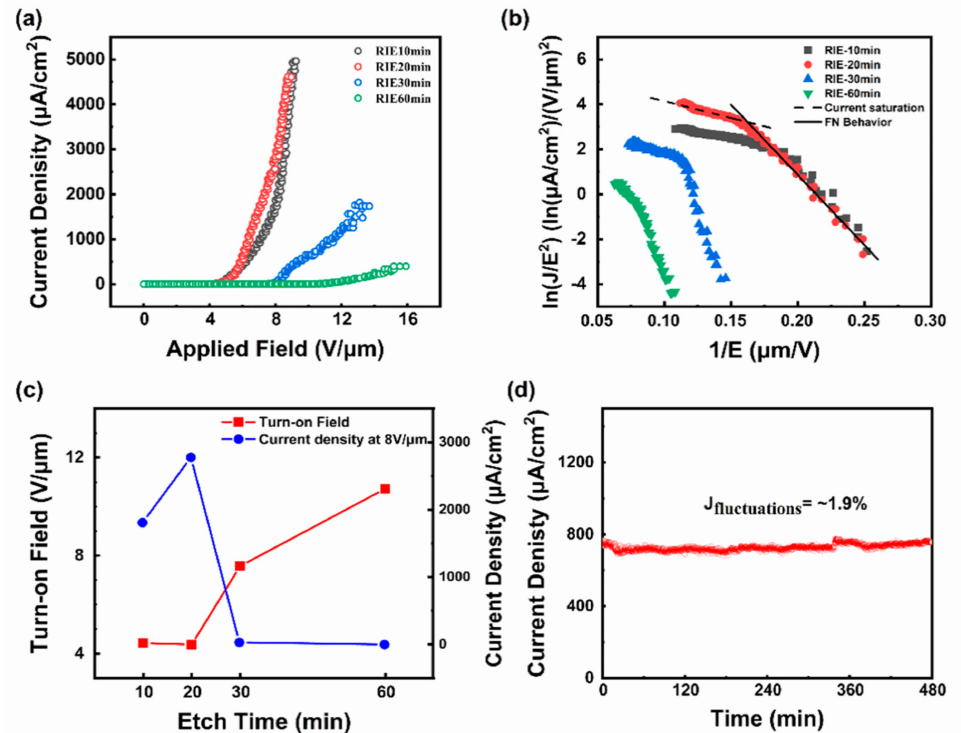
Figure 5. ( a ) Typical current density (J)- electric field (E) curve of the SiC nanoarrays fabricated as a function of etching time with the anode-cathode separation distance fixed at 300 µ m. ( b ) The corresponding Fowler–Nordheim (F–N) plots with different etching times. ( c ) The E to and current density applied 8 V/ µ m of nanoarrays in different etching times. ( d ) The current emission stabilities of SiC nanoarrays at an etching time of 20 min over 8